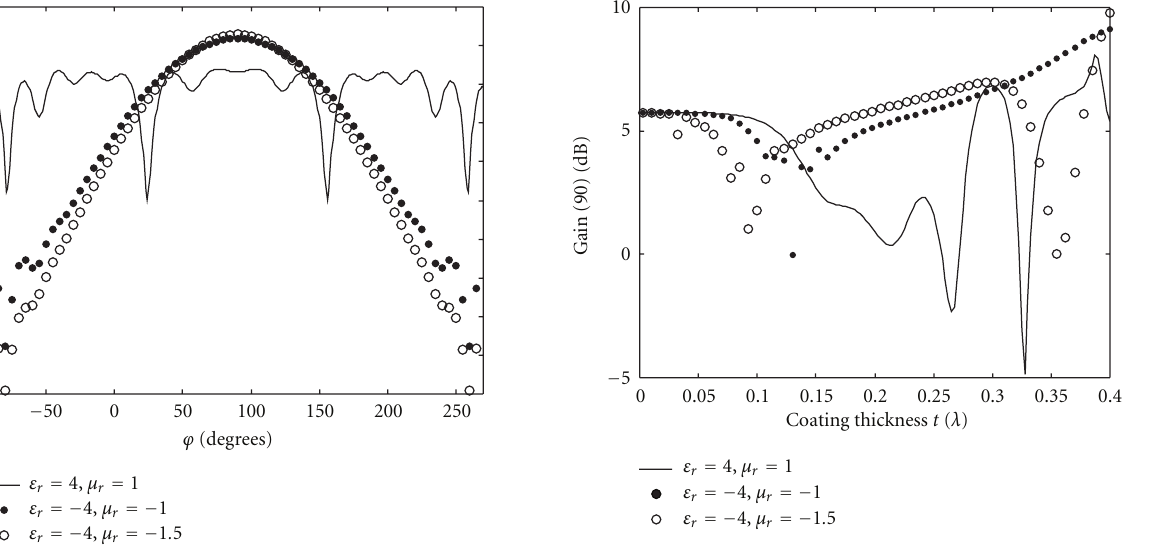
Figure 4: Gain versus coating thickness for an axially slotted elliptic cylinder coated with conventional dielectric, magnetic and nonmagnetic metamaterials. a c = λ , b c = λ /2, b = b c + t , ν 0 = 90 ◦ , and α = 2 . 8657 ◦ .